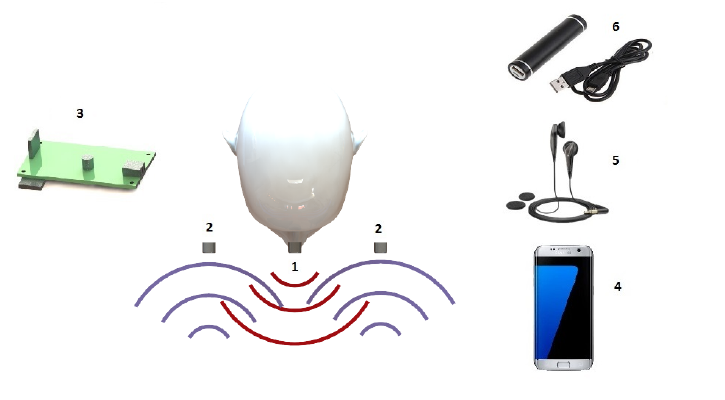
Figure 10. Main parts of the system: 1–transmitter, 2–receivers, 3–logic unit, 4–smart phone, 5–headphone, 6–power